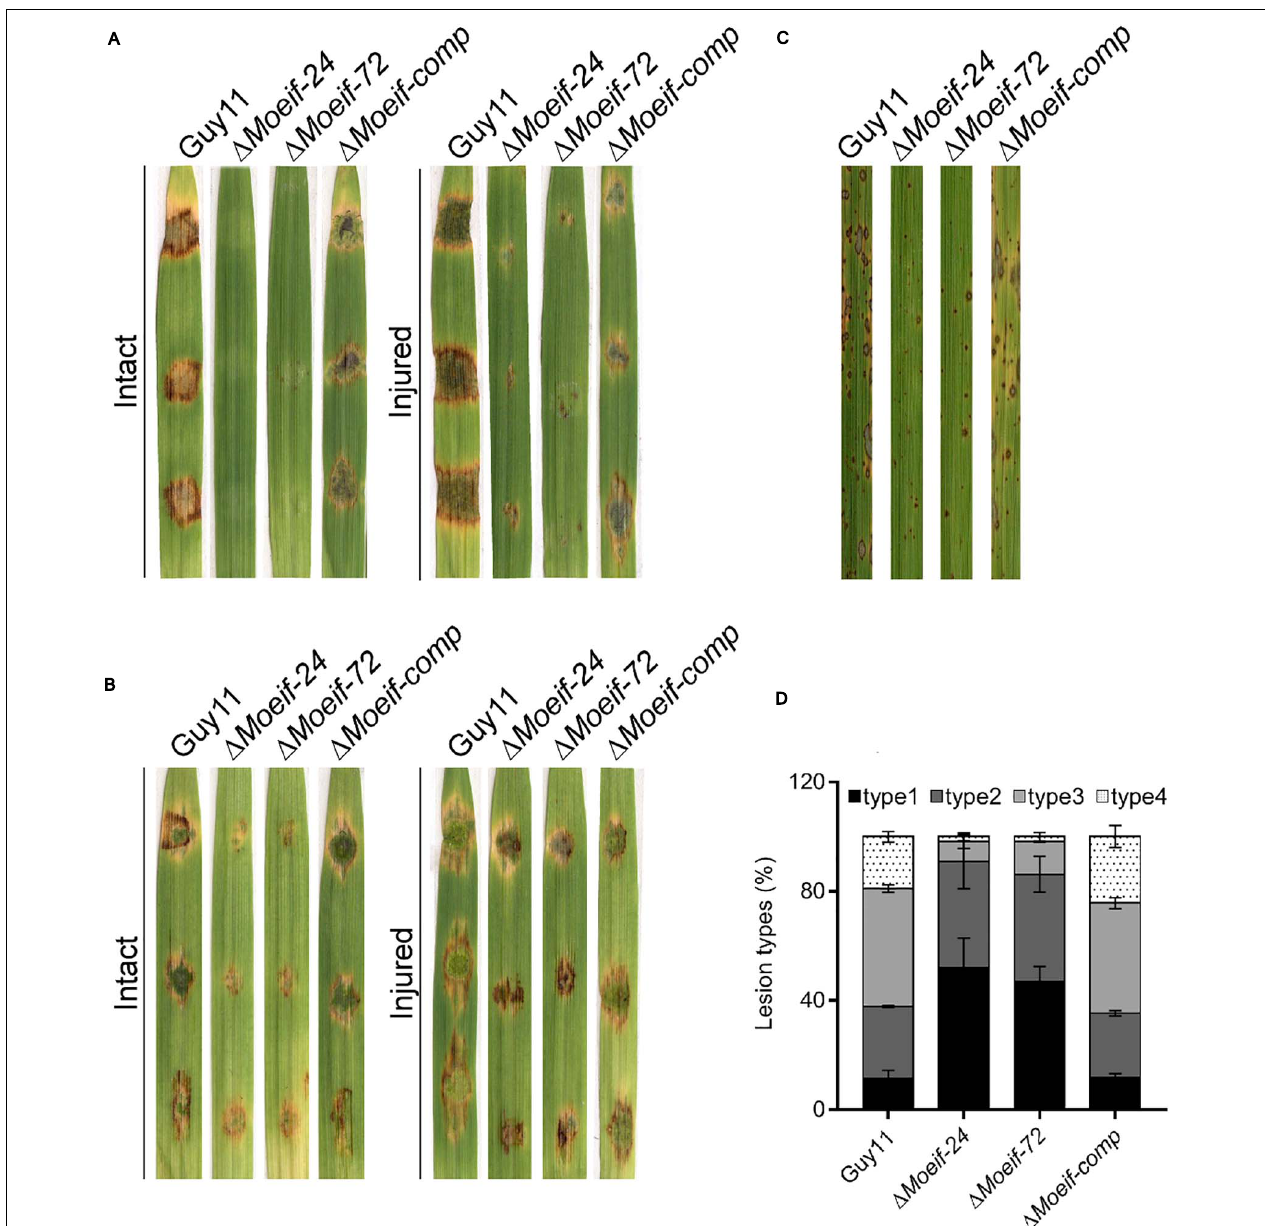
FIGURE 5 | Contribution of MoeIF4E3 to promote the pathogenicity of M. oryzae . (A) Represent the hyphae mediated blast lesions on intact and injured barley leaves inoculated with mycelial plugs from (cid:49) MoeIF4E3 mutants ( (cid:49) Moeif-24 , (cid:49) Moeif-72 ), (cid:49) Moeif-comp, and the wild-type strain. (B) Depicts the blast lesions due to spore inoculation of respective mutant, complemented strain, and Guy11 on intact and injured barley leaves. (C) Portrays disease lesions on 2 weeks old rice leaf from a susceptible rice cultivar CO39 after spraying with conidia suspensions of Guy11, (cid:49) MoeIF4E3 mutants, and the complemented strain. Photographs were taken after 6 days of inoculation. (D) A graph for scoring lesion types per 1.5 cm 2 (1 to 4) from rice leaves inoculated with a spore suspension of Guy11, mutants, and complementation